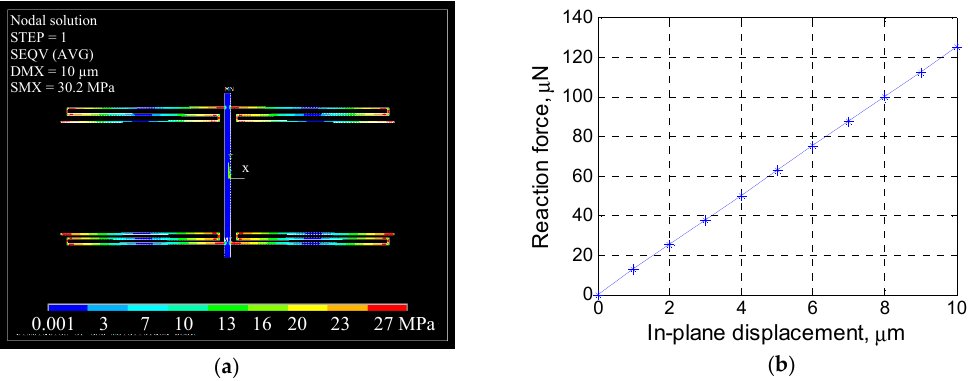
Figure 2. Finite element modelling (FEM) of the MEMS quasi-static performance: ( a ) In-plane (x–y plane) stress in the MEMS suspending system (here, DMS is the main shaft’s maximum in-plane displacement); ( b ) relationship between the MEMS reaction force (corresponding to the probing force) and the MEMS in-plane